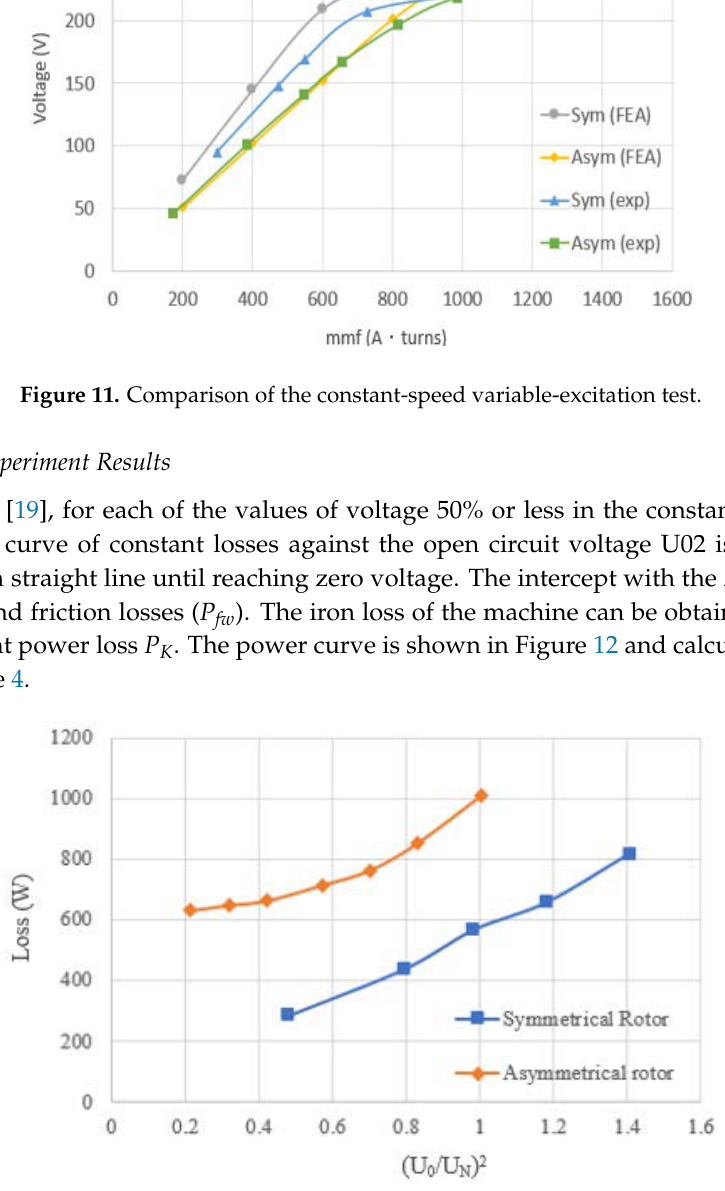
Table 4. Comparison of the iron loss results. Item